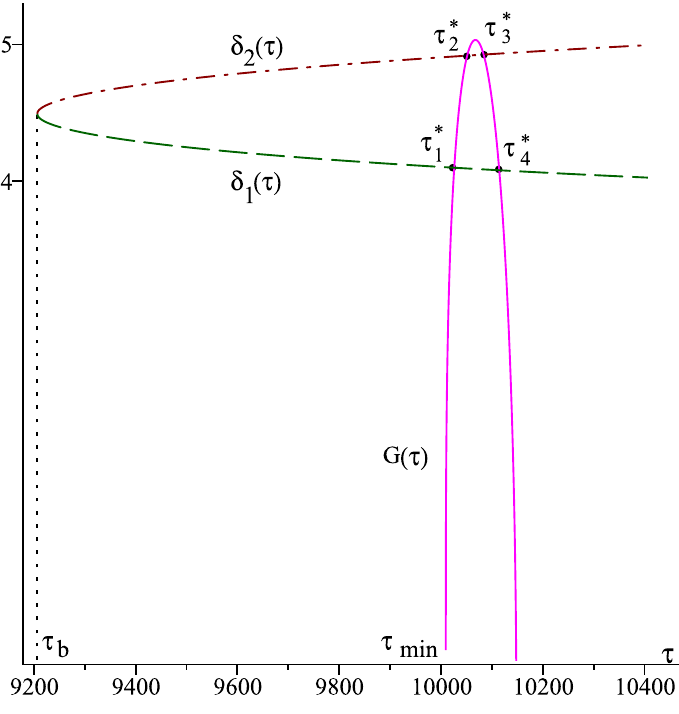
Figure 3. Graph of the function G ( τ ) and of the solutions δ i ( τ ) , i =